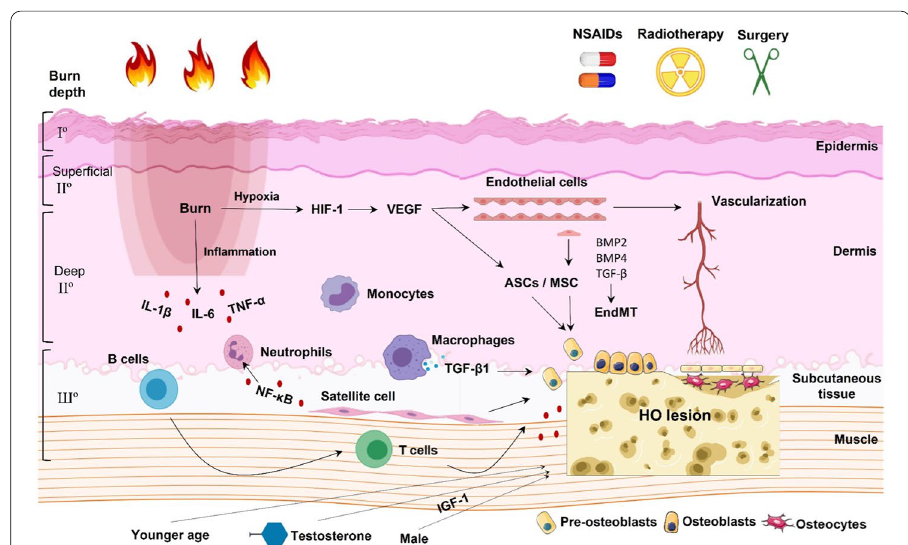
Fig. 2 Schematic diagram showing the signaling pathways and mediators involved in burn-induced HO. Current evidence for mechanisms directly involved in burn-induced HO suggests four main pathways: vessel- and endothelial cell-based pathways; immune cell-based pathways; muscle satellite cell-based pathways; and other factors